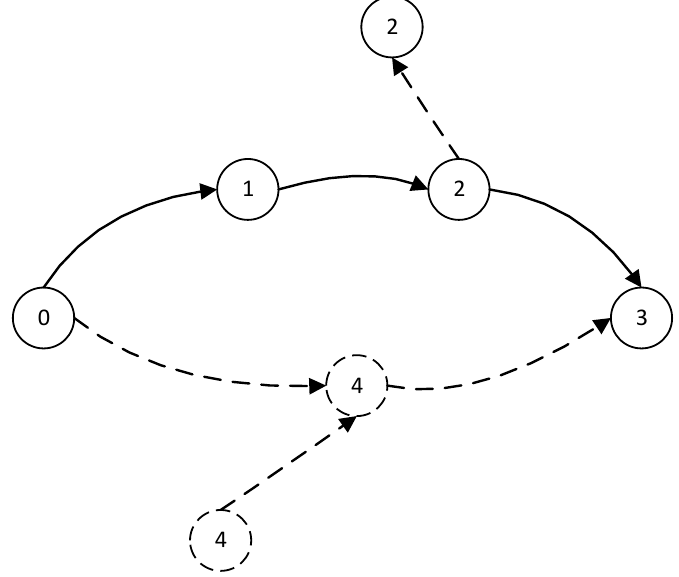
Figure 2. Schematic diagram of node path changes.